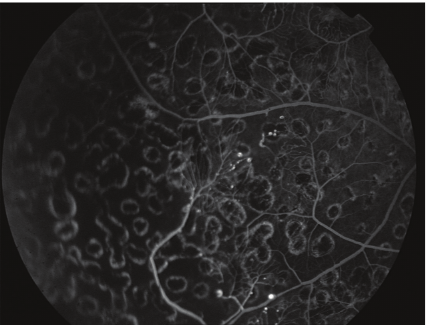
Figure 3: Argon laser photocoagulation was performed to the ischemic areas of the temporal peripheric retina of the right